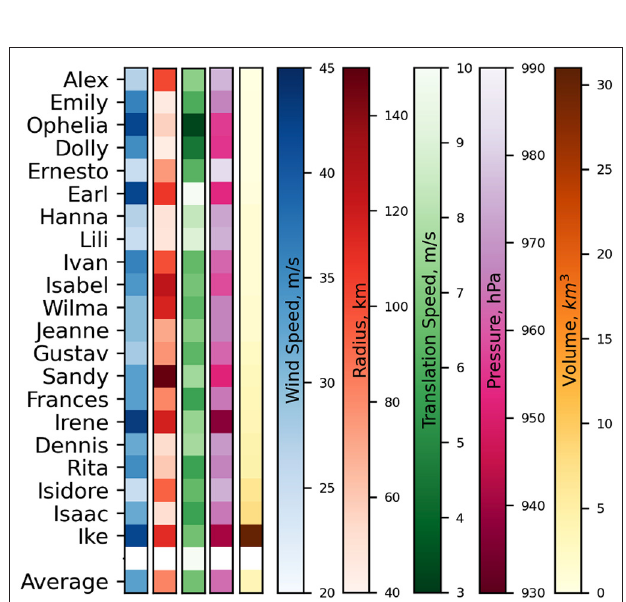
FIGURE 10 | Average hurricane characteristics of each simulated storm arranged from top to bottom by increasing inundation volume of the PGW simulations. Magnitudes of hurricane characteristics that theoretically contribute positively to larger surges (e.g., higher wind speeds, larger radii, and slower translation speeds) are depicted by darker hues.